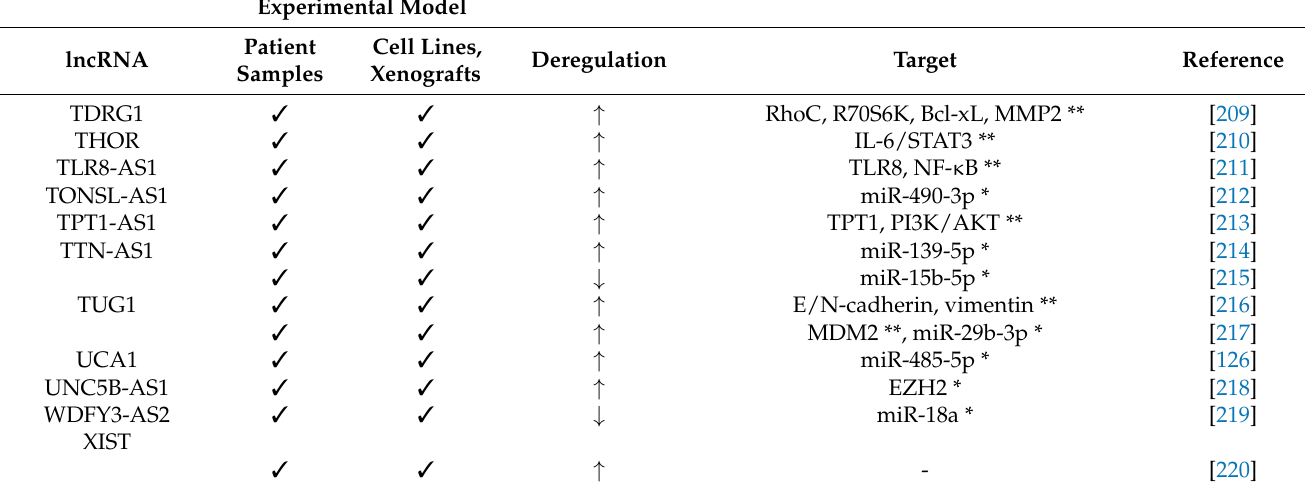
* target (connection) predicted by bioinformatics tools like TargetScan, DIANA-MicroT-CDS, miRWALK, miRDB, RNA22, PicTar, mi- croRNA.org, PITA, miRNAnda, Starbase, etc. and/or dual-luciferase assay; ** connection predicted by expression correlation, not part of the study; ↓ expression downregulation between compared specimens; ↑ expression upregulation between compared specimens; (cid:51) included in the study.